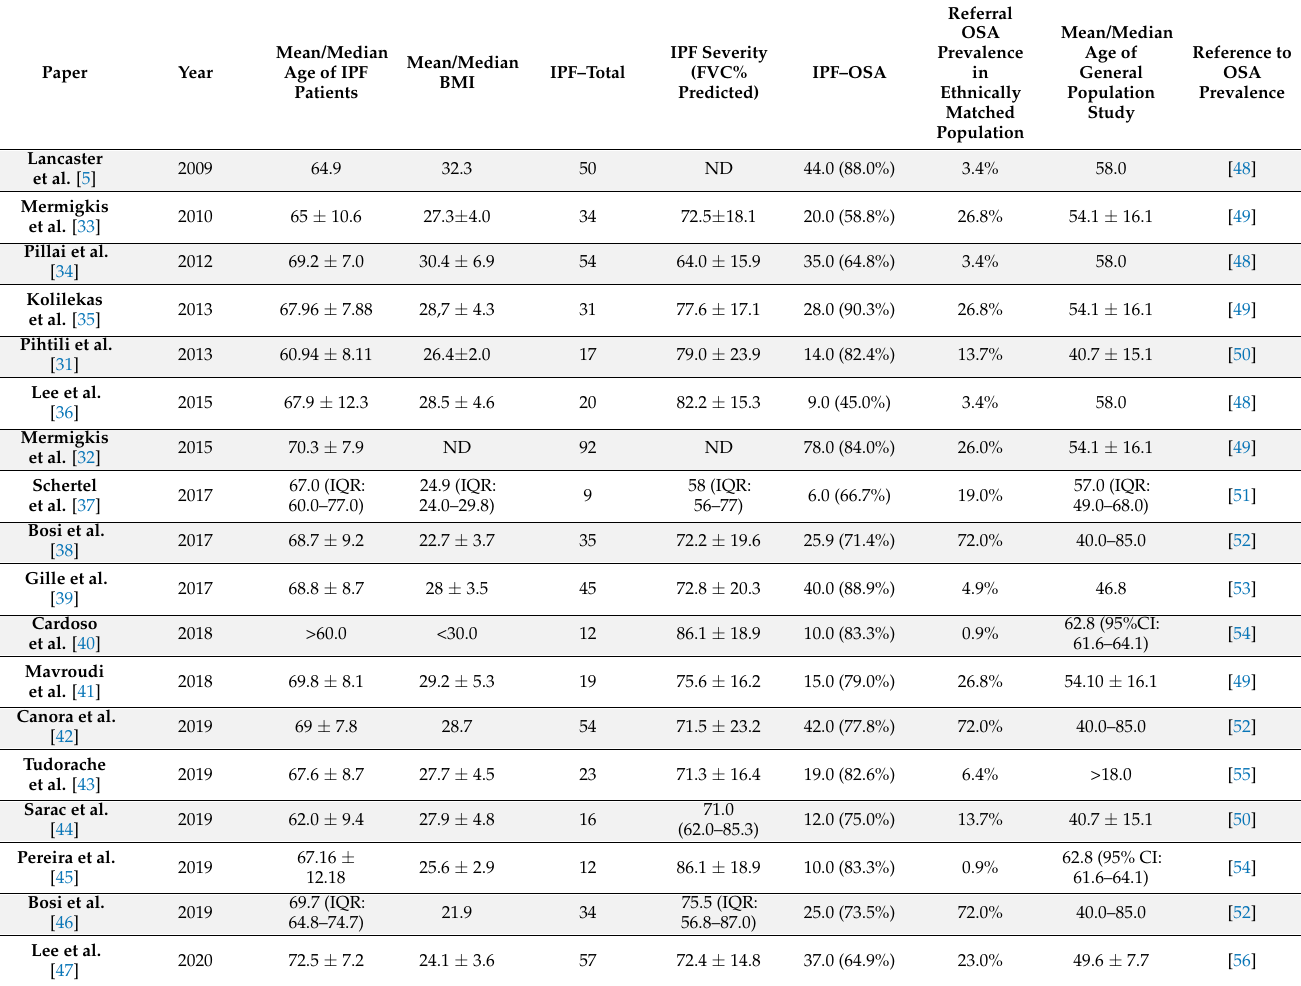
Table 2. Characteristics of eligible studies. BMI, body mass index; CI, confidence interval;